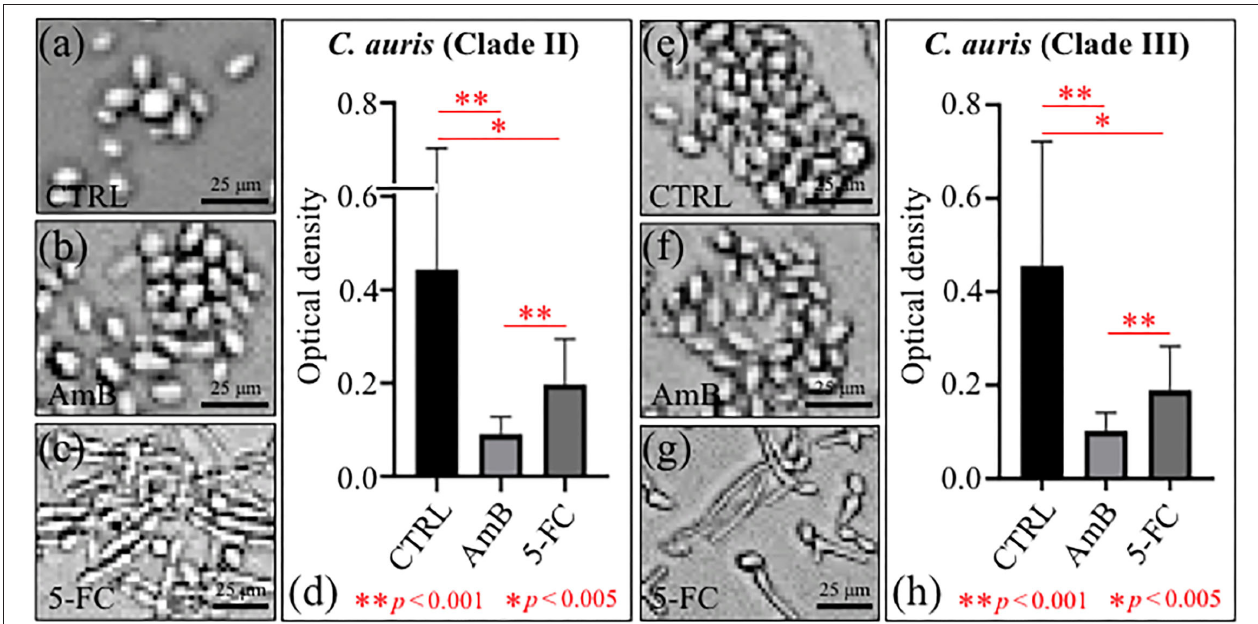
FIGURE 1 | Optical micrographs of C. auris cultures before (CTRL label) and after 24h treatment with different drugs (cf. labels): Clade II (a–c) and Clade III (e–g) ; OD plots obtained from microbial viability assays are given in (d,h) for Clades II and III,